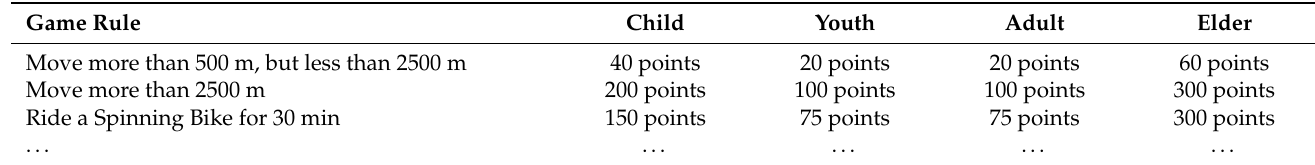
Table 1. Illustration of the point system in an UHG game.